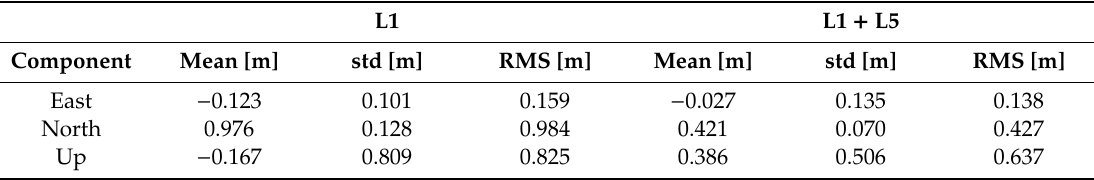
Table 9. Positioning results considering the GPS + GLONASS + Galileo constellations. L1 + L5 frequencies are referred to only for GPS and Galileo constellations.